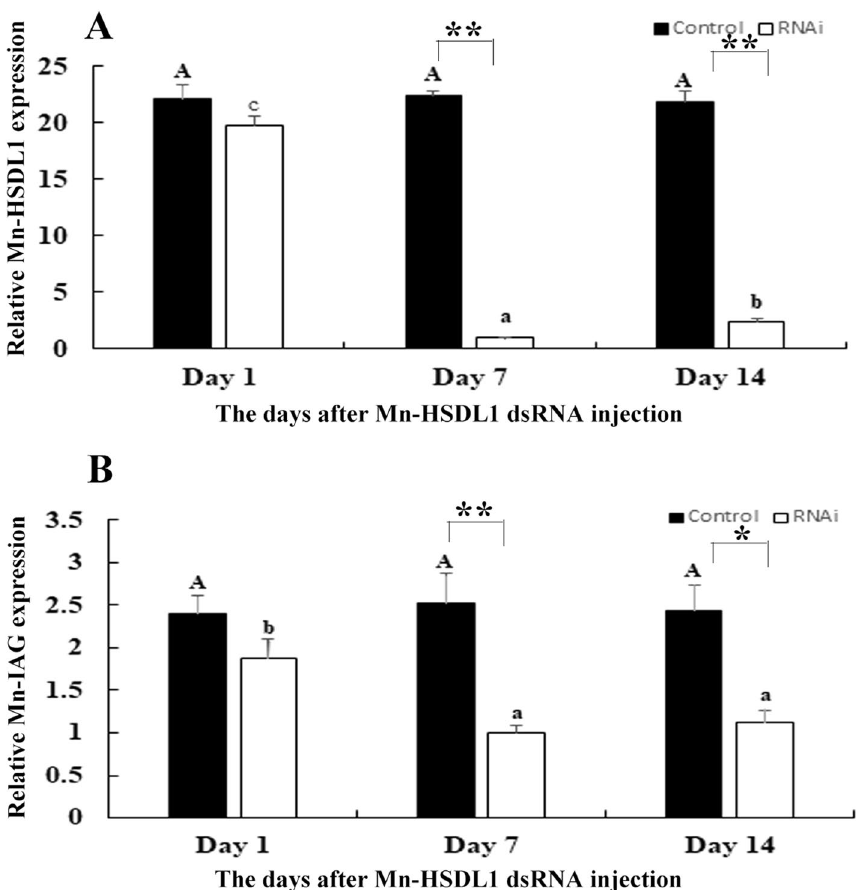
Figure 6. Measurement of the expression levels of Mn-HSDL1 and Mn-IAG at different days after Mn-HSDL1 dsRNA injection. EIF transcript level was used to normalize the amount of Mn-HSDL1 and Mn-IAG mRNA expression. Three separate individuals were performed for each tissue, and data are shown as mean ± SD (standard deviation) . Capital letters and lowercase indicated expression difference between different days after GFP injection in control group and Mn-HSDL1 dsRNA injection in RNAi group, respectively. * ( P < 0.05) and ** ( P < 0.01) indicates significant expression difference between the RNAi group and control group at the sample day. ( A ) Measurement of the expression levels of Mn-HSDL1 at different days after Mn-HSDL1 dsRNA injection. ( B ) Measurement of the expression levels of Mn-IAG at different days after Mn-HSDL1 dsRNA